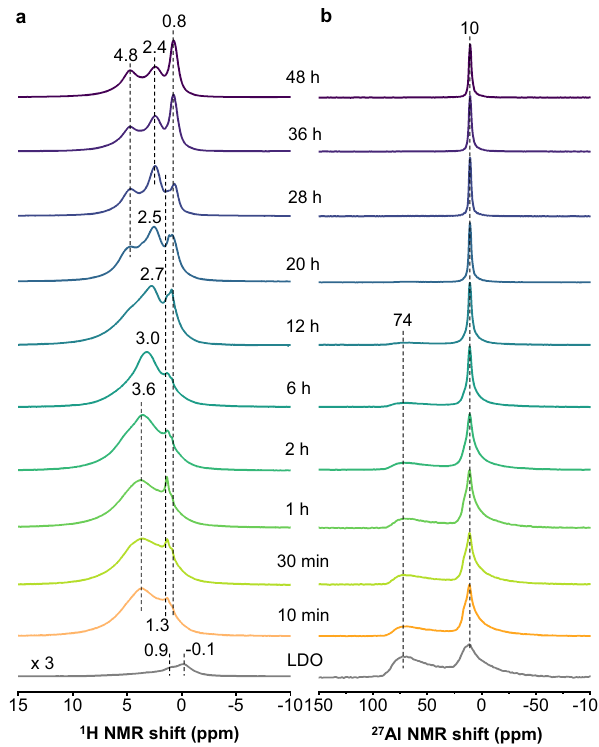
Fig. 4 | Ex situNMR spectra of rehydrated Mg/Al-LDO. a 1 H and b 27 Al MAS NMR spectra of rehydrated Mg/Al-LDO for different rehydration time t . Mg/Al-LDO was rehydrated with NaNO 3 in D 2 O solution (mass ratio of LDO to D 2 O is 1:100).